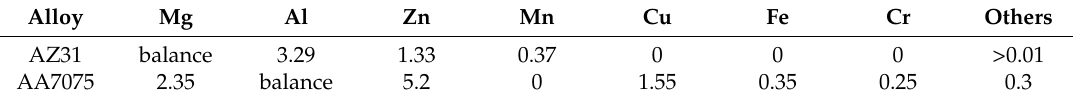
Table 1. Chemical composition (wt %) of the AZ31 cast alloy and the AA7075 coating powder.